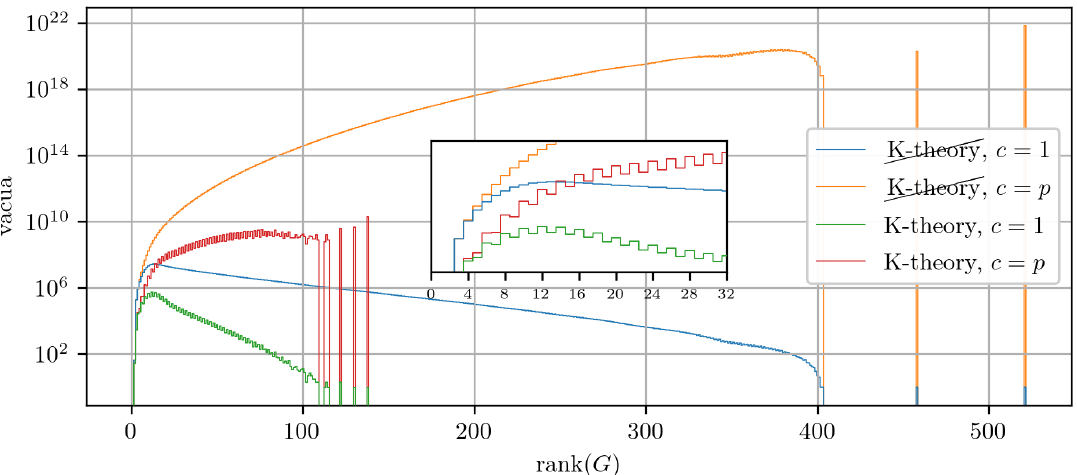
Figure 4. Number of vacua for T = 8 and b i = (0 , 0 , 0) as a function of the 4D gauge group rank. Note the suppression of odd rank when the K-theory condition is